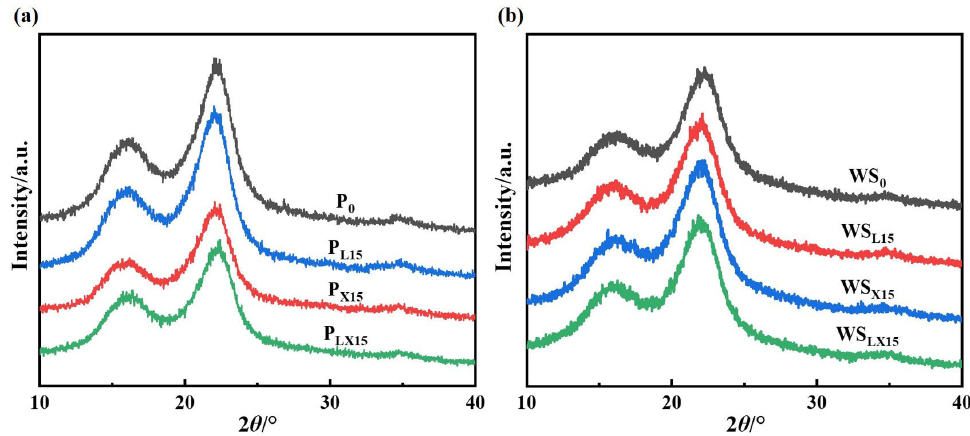
Figure 5. XRD patterns: ( a ) pulp and ( b )wheat straw before and after pretreatment with bio-en-